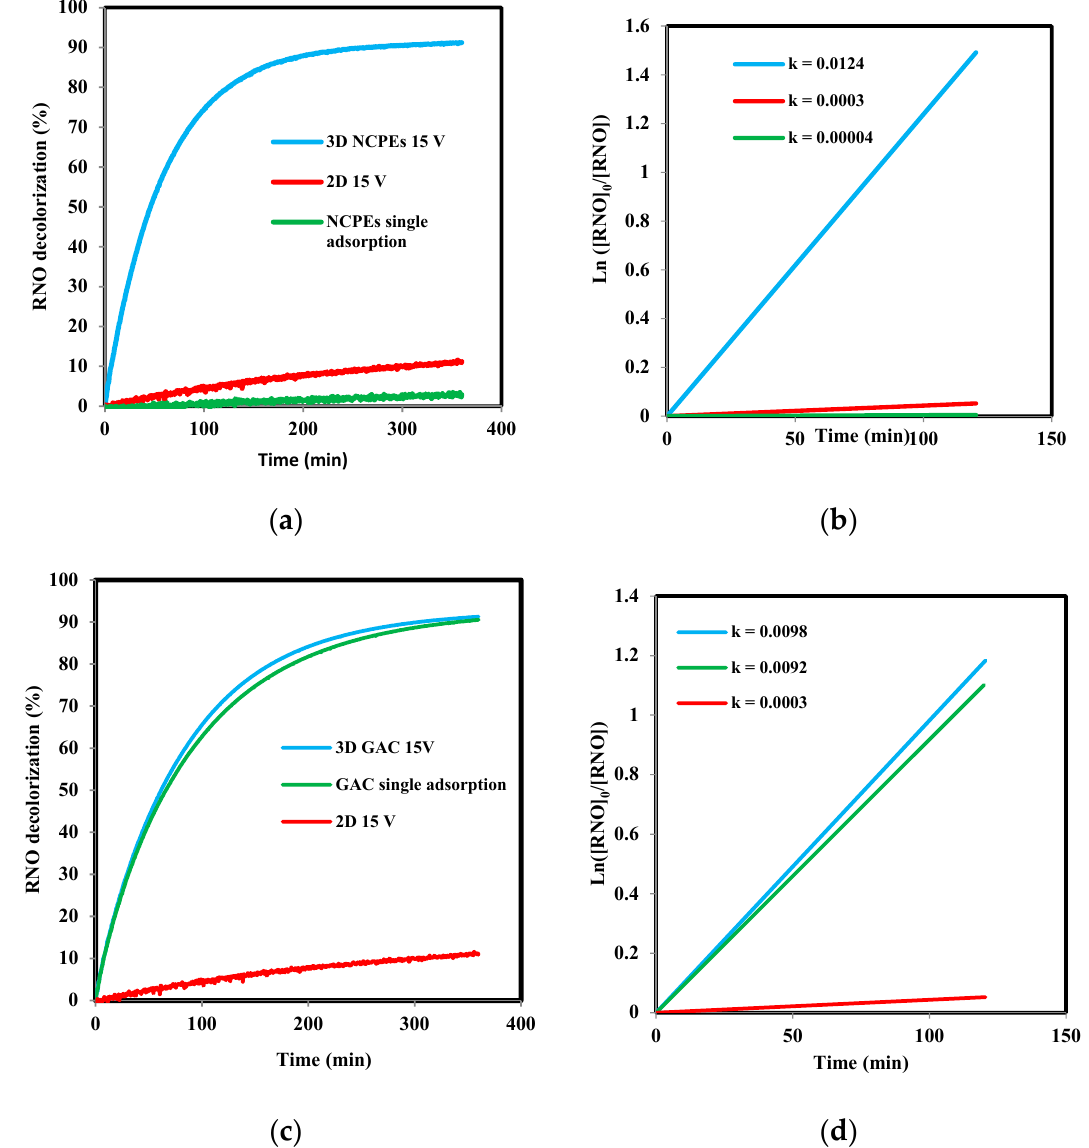
Figure 3. ( a,b ) p-nitrosodimethylaniline (RNO) decolorization with corresponding kinetic rates in 3D systems using nitrogen-doped graphene-based particle electrode (NCPE) as particle electrodes; ( c,d ) RNO decolorization with corresponding kinetic rates using granular activated carbon (GAC) as particle electrodes in 3D systems.